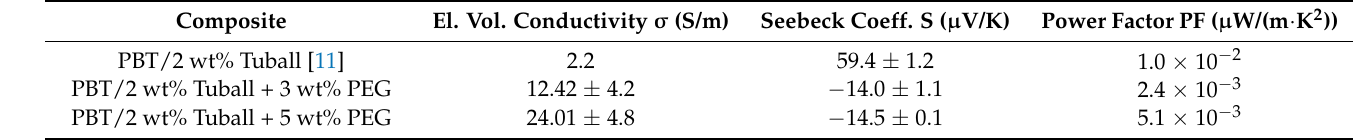
Figure 10. Transmission light microscopy images of PBT/2 wt% Tuball™ with different amounts of PEG: ( a ) without PEG and ( b ) 2 wt% PEG. Table 4. TE properties of PBT composites with SWCNT Tuball™ and PEG in different quantities.